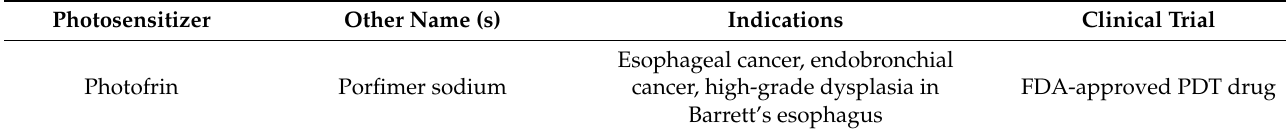
Table 1. Recent outcomes of clinical trials with